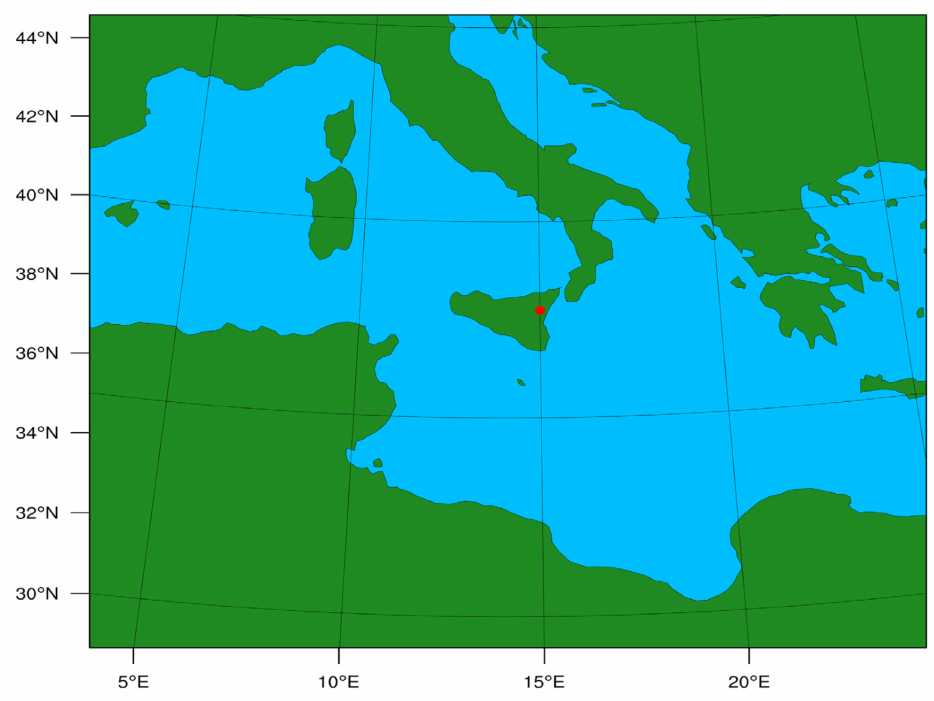
Figure 2. Model domain and Etna location (red point) on Lambert Conformal